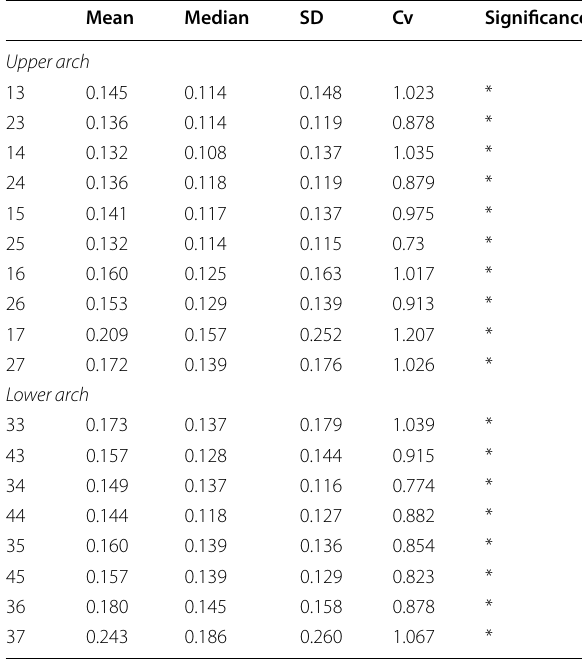
Table 1 Descriptive analysis on the average imprecision of linear distances